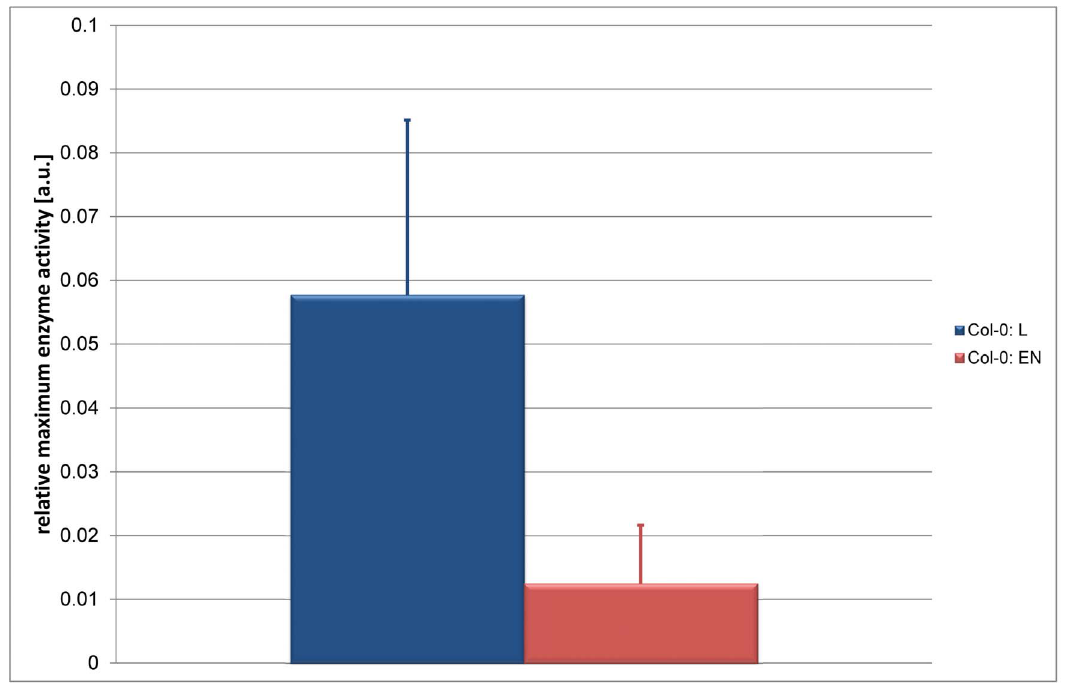
Figure 3. Relative activity of the pyruvate dehydrogenase complex in Col-0 under conditions of light and extended night. Enzyme activity is given in arbitrary units which are normalised to gram fresh weight. The blue bar shows relative activity under normal light condition, the red bar shows activity under condition of extended darkness. The difference of relative activity is significant (p , 0.05) and bars represent means 6 SD (n =5).